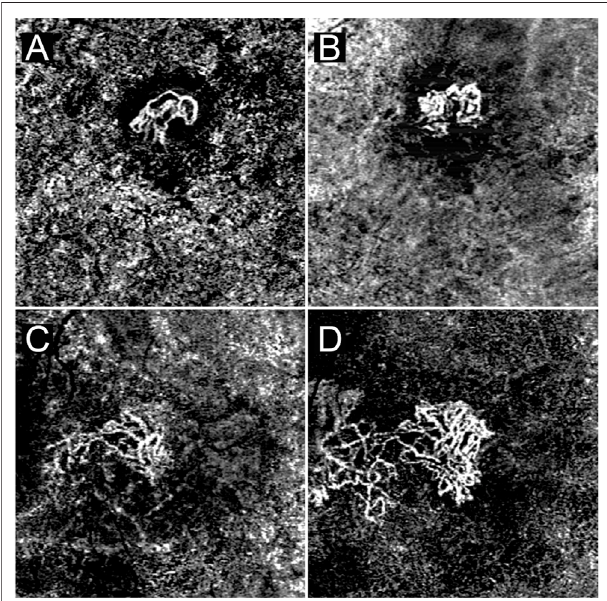
FIGURE 4 | A case of MNV characterized by MNV VT < 8.40 and predominant high MNV re fl ectivity signal (A) . This lesion experienced extremely minor changes in size over the follow-up (B) . A case of MNV characterized by MNV VT > 8.40 and easily identi fi able low MNV re fl ectivity signal regions (C) . By the end of the follow-up the MNV has undergone a remarkable increase in size, closely matching the sectors displaying a low re fl ectivity signal (D)